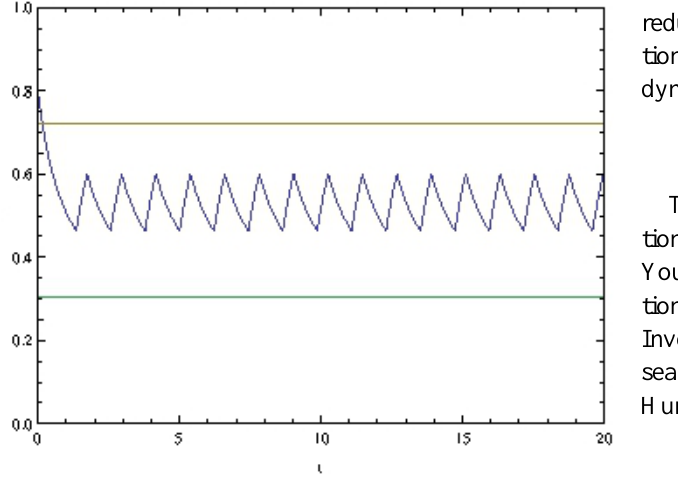
Fig. 7. The time evolutions of the density of infection with I (0) =